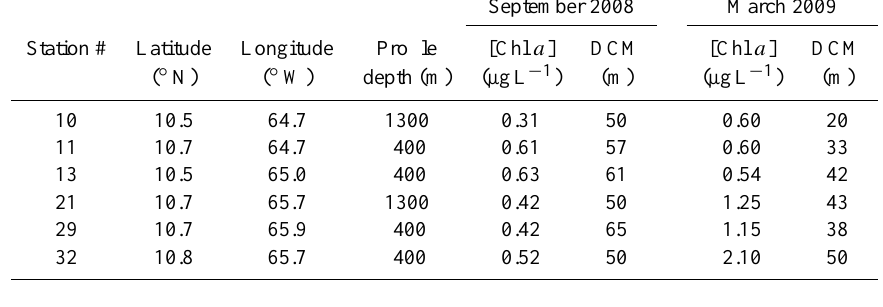
Table 1. Location, profile depth, and chlorophyll a concentration at the depth of chlorophyll maximum (DCM) at stations sampled for N xs during September 2008 and March 2009 in the Cariaco Basin.